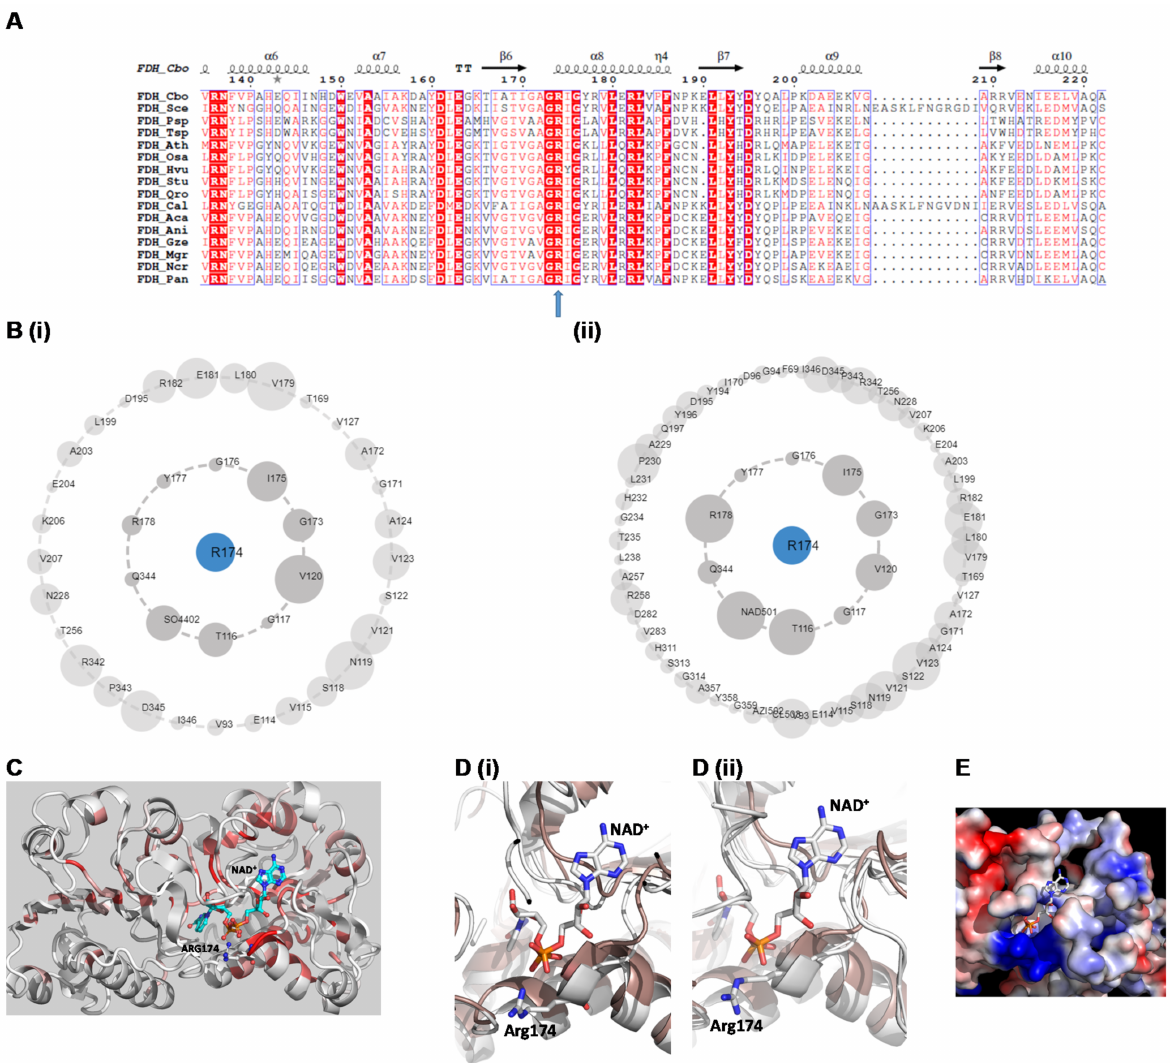
Figure 2. Structural analysis. ( A ) Aminoacid sequence alignments of NAD + -binding region of plant, bacteria, fungi and yeasts FDHs. Abbreviations and National Center for Biotechnology Information (NCBI) accession codes are: FDH_Cb, CAA09466; FDH_Sc, NP_015033, FDH_Pan, P33677; FDH_Cal, XP_711169; FDH_Psp, P33160; FDH_Tsp, BAC92737; FDH_Ath, NP_196982; FDH_Stu, Q07511; FDH_Osa, NP_001057666; FDH_Qro, CAE12168; FDH_Hvu, Q9ZRI8; FDH_Aca, AAV67968; FDH_Ani, XP_664129; FDH_Mgr, AAW69358; FDH_Gze, XP_386303; FDH_Ncr, XP_961202. The alignments were created using Clustal O. The secondary structure of Cb FDH (PDB code 2FSS) and numbering are shown above the alignment. The arrow below the alignments depicts Arg174. ( B ) Asteroid Plot of interactions of Arg174 in NAD + -free ( i ) (Protein Data Bank code: 5dna) and NAD + -bound ( ii ) (Protein Data Bank code: 5dn9) structures. The inner ring indicates first shell of immediate atomic contacts. The outer ring indicates second shell of extended atomic contacts. The size of the circle is proportional to the total number of contacts that each residue is involved in with any of the residues in the ring inward to it. The diagrams were created by Protein Contact Atlas [38]. ( C ) Diagram of the subunit of Cb FDH with NAD + bound to the active site. ( D ) Movement of Arg174 upon NAD binding. ( i ) The conformation of Arg174 in NAD + -bound structure (PDB code: 5dn9, colored grew). ( ii ) The conformation of Arg174 in NAD + -free structure (PDB code: 5dna, colored brown). Both structures (5dn9 and 5dna) were superimposed. ( E ) Coulombic surface coloring of the electrostatic potential in the NAD + binding site. NAD + is shown in stick representation and colored according to the atom